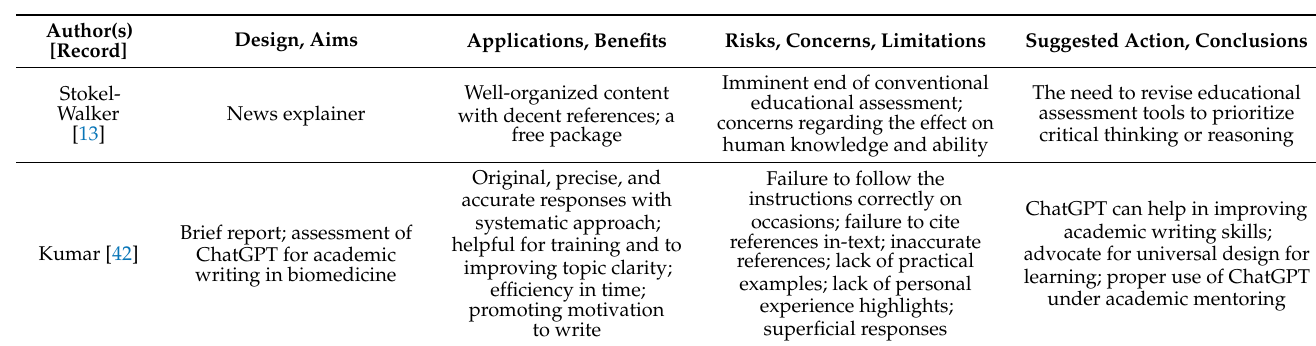
Table 2. A summary of the main conclusions of the included records comprising research articles, commentaries, news articles, perspectives, case studies, brief reports, communications, opinions, or